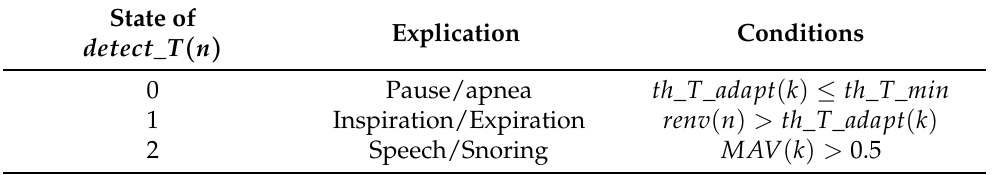
Table 1. Temporal detection states.